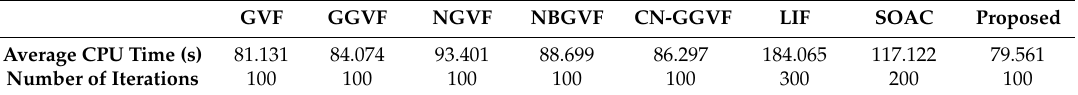
( d ) ( e ) Figure 16. Evolution of the contour and segmentation results of natural images and medical images using proposed method.